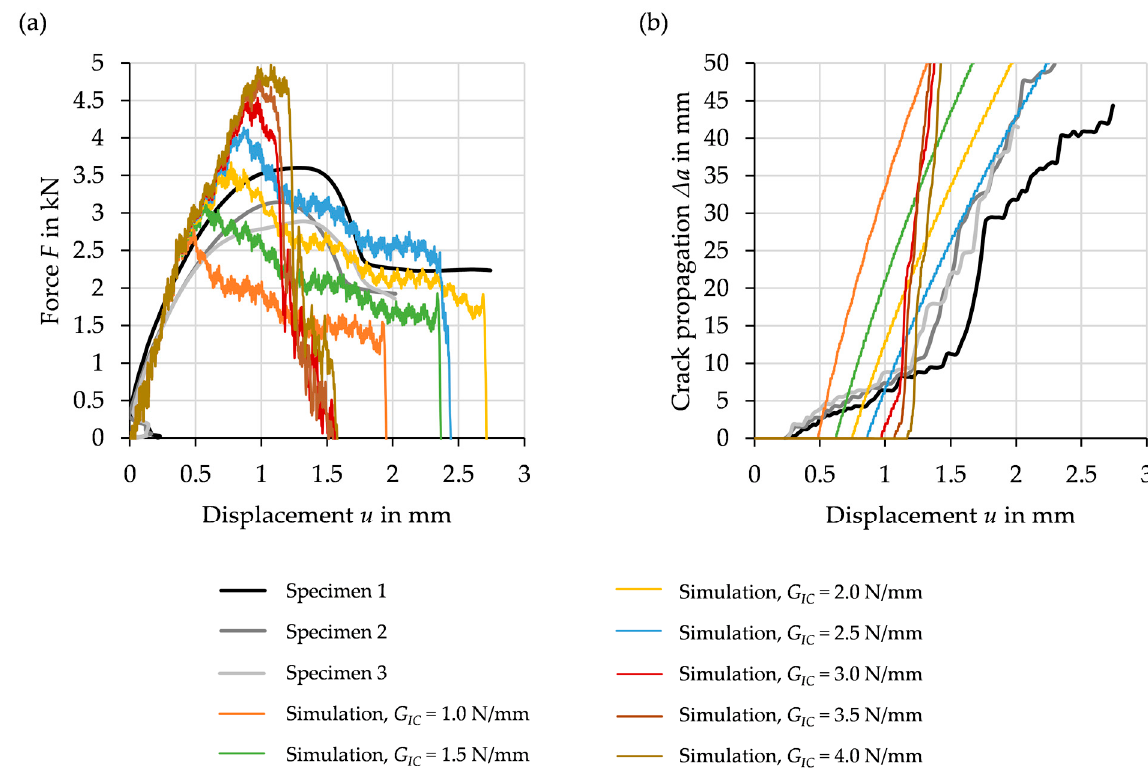
Figure 12. Influence of the critical energy release rate in mode I on the ( a ) force-displacement and ( b ) crack propagation- displacement behavior, for T = 55 MPa.